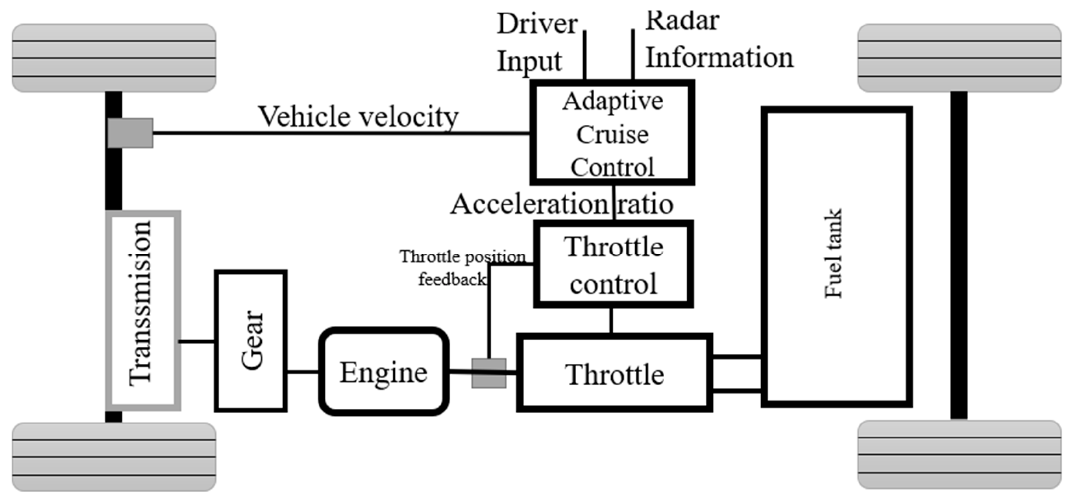
Figure 2. ICE propulsion system with adaptive cruise control.